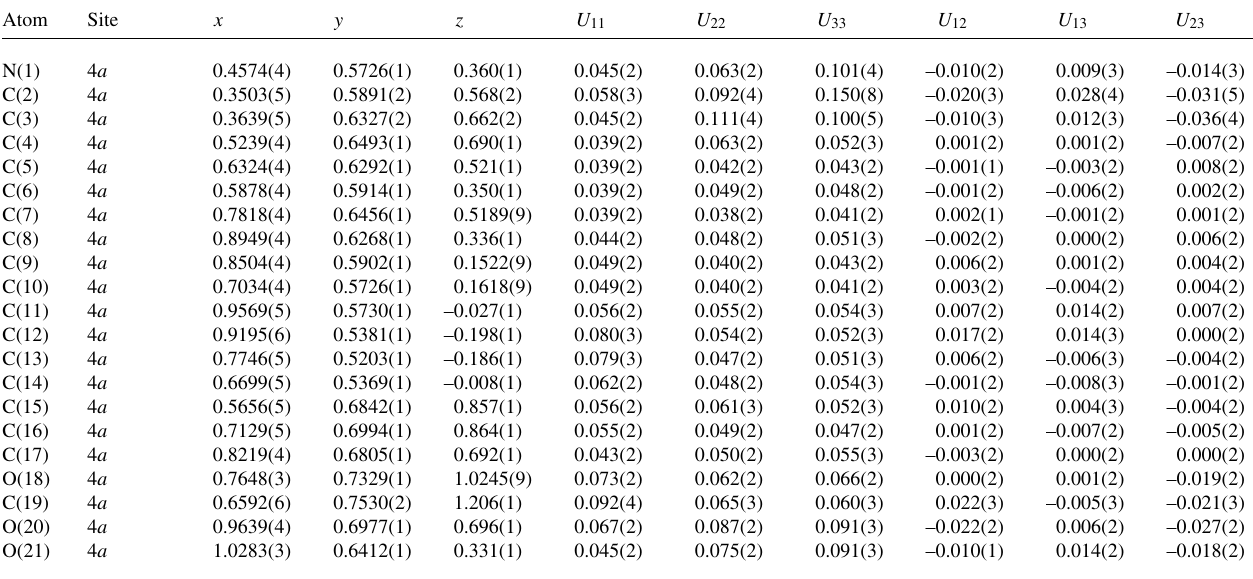
Table 3. Atomic coordinates and displacement parameters (in Å 2 )